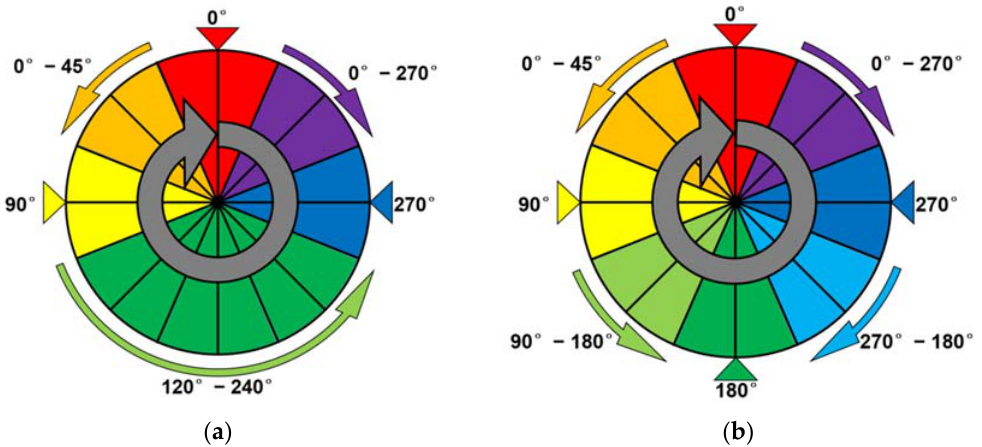
Table 3. Sound representations of 8-color wheel codes.